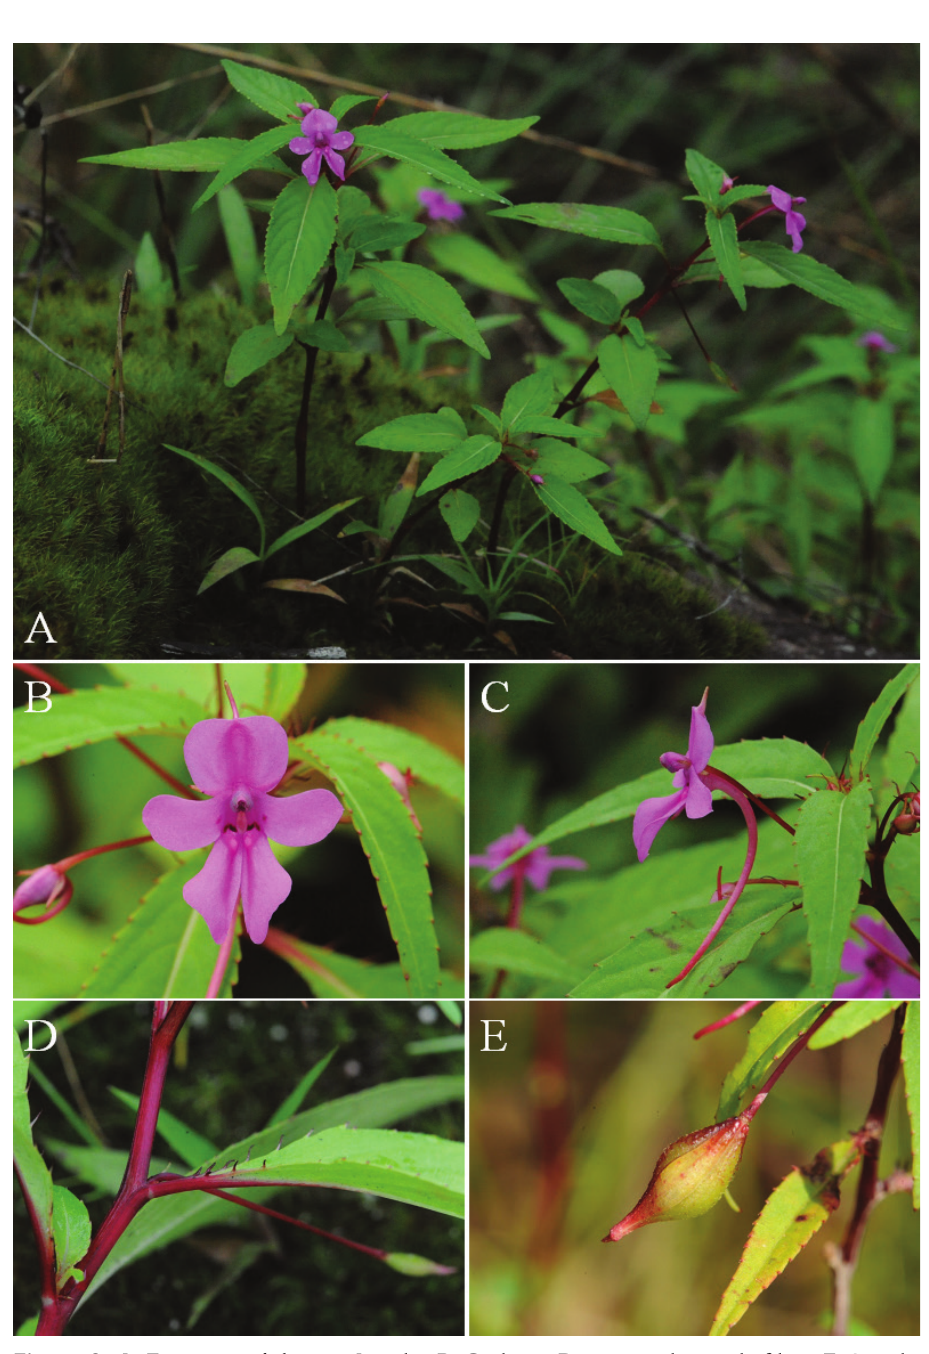
Figure 2. A–E Impatiens bokorensis A Habit B–C Flower D strigose-ciliate at leaf base E Capsule: Photos by Seong-Hyun